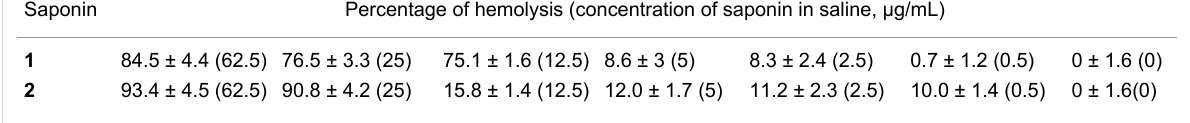
Table 3: Hemolytic activities (%) of compounds 1 and 2 at different concentrations. The hemolytic activities of saline and distilled water were used as minimal and maximal hemolytic controls, respectively. n = 3 tests. Mean p < 0.05 vs saline group.